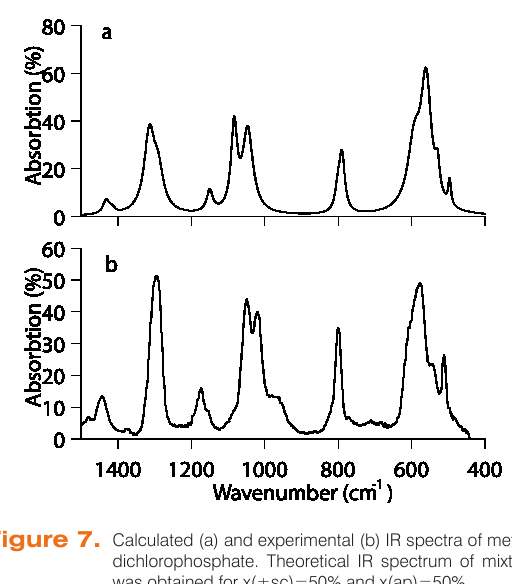
Figure 7. Calculated (a) and experimental (b) IR spectra of methyl dichlorophosphate. Theoretical IR spectrum of mixture was obtained for x(±sc)=50% and x(ap)=50%.